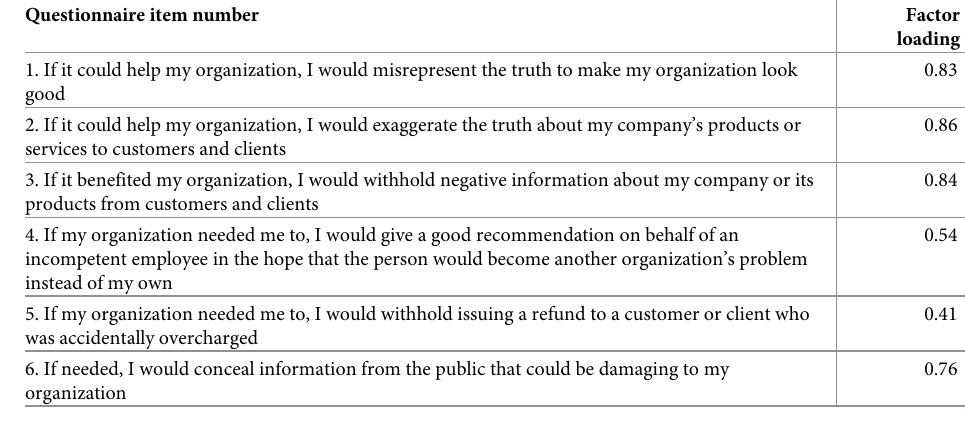
Table 3. Values of the factor loadings obtained via an exploratory factor analysis of unethical pro-organizational